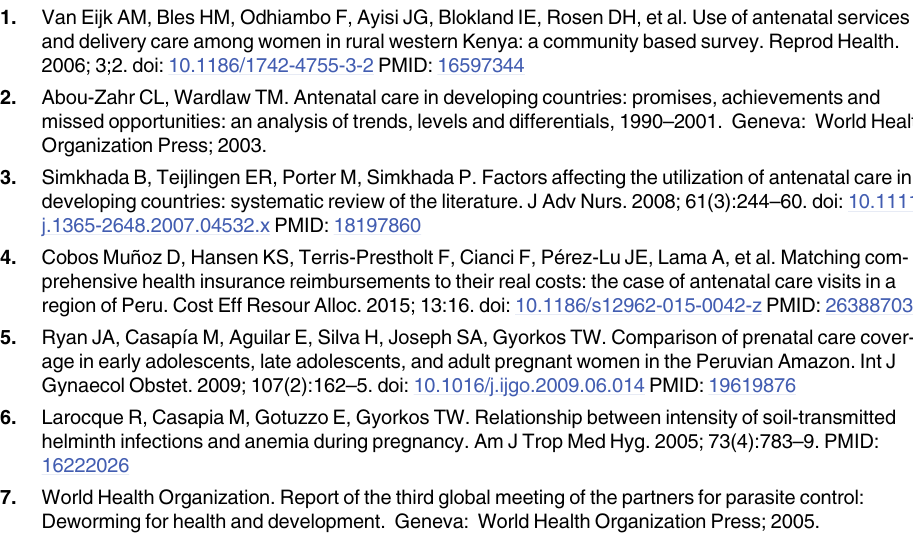
S1 Fig. Proportions of pregnancies of early adolescent, late adolescent and adult women, by trimester at first ANC visit, in the community of Bele´n, Iquitos, Peru, 2010 to